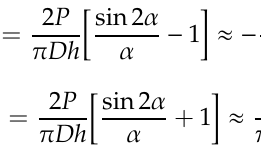
Figure 2. Acoustic emission (AE) sensors setup for tests under different loading methods: ( a ) AE sensors placement in the DTT, ( b ) AE sensors locations in the ITT, ( c ) Overall arrangement of the experiment (a UCT is shown as an